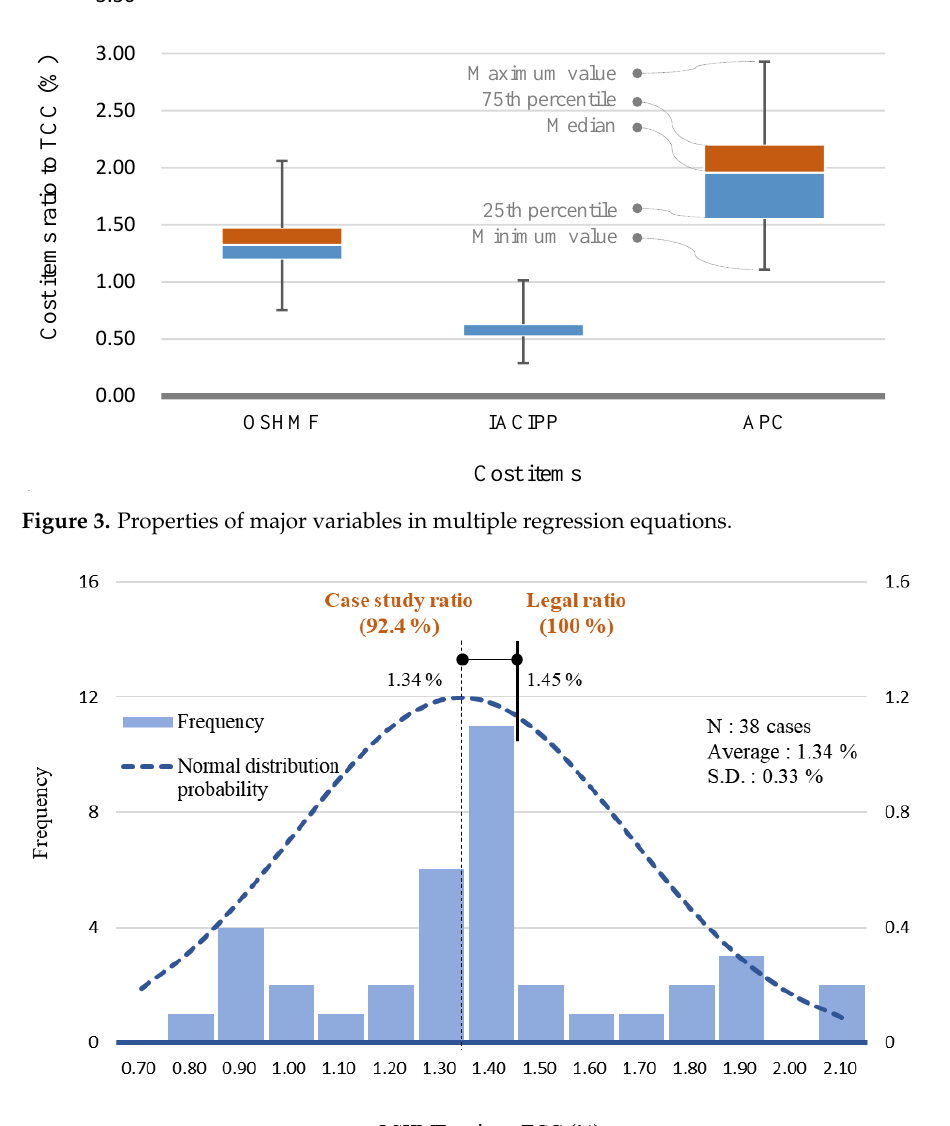
Table 8. Multiple regression analysis outcomes.